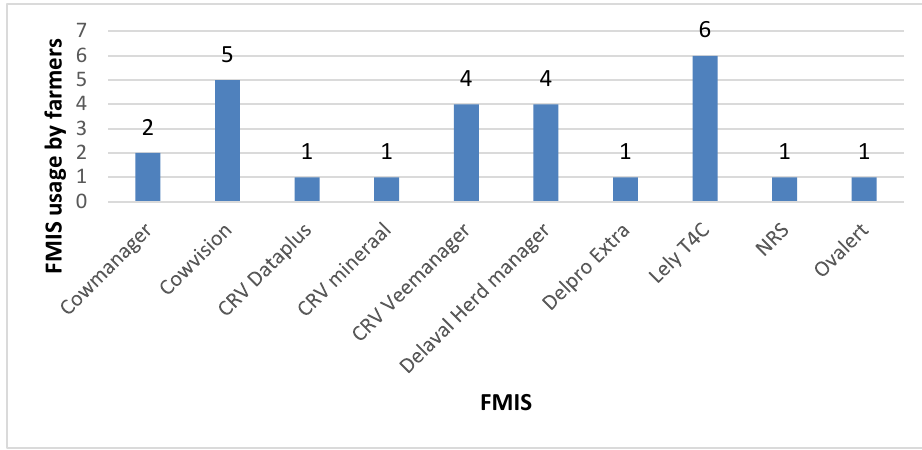
Figure 4. The use of different FMIS by the farmers (n = 15).